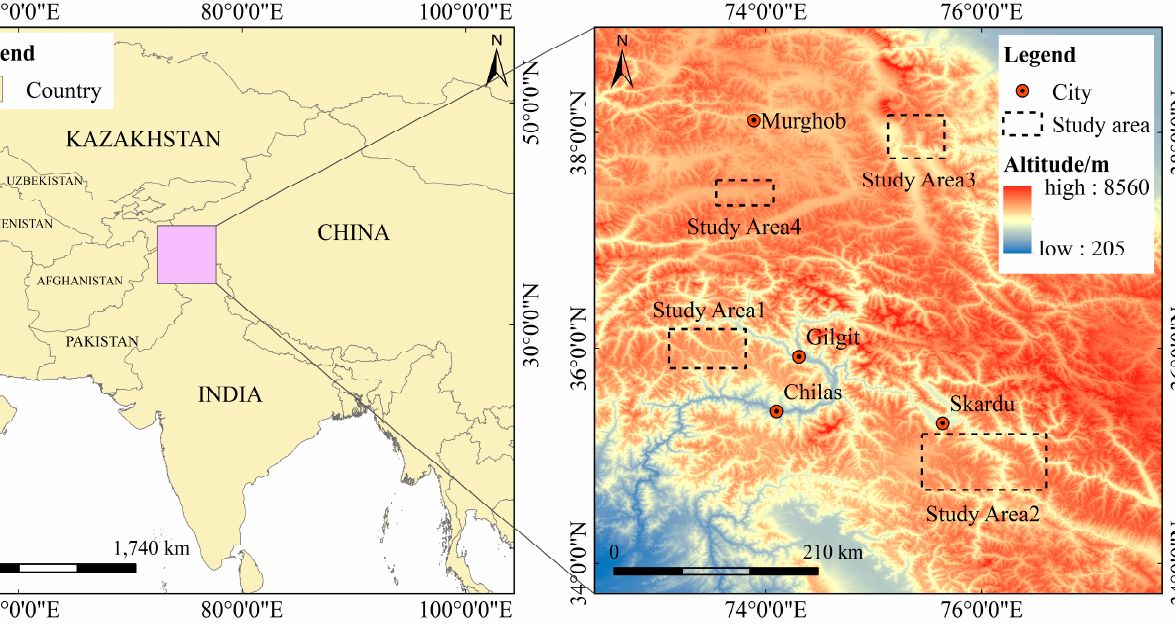
Figure 1. General geographic situation of the whole study area.